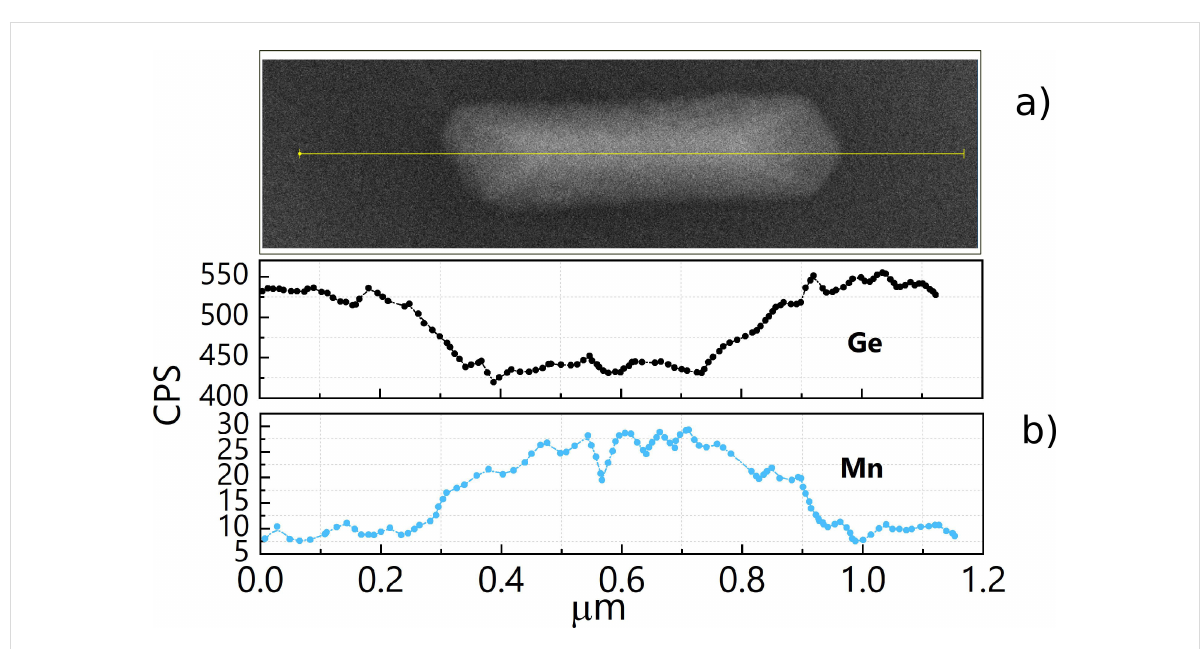
Figure 4: (a) SEM image of a typical NW, ≃ 700 nm long, obtained by deposition of a 4.5 ML thick Mn film followed by annealing at 650 °C for 15 min. (b) Mn and Ge EDX line profiles along the yellow line drawn in